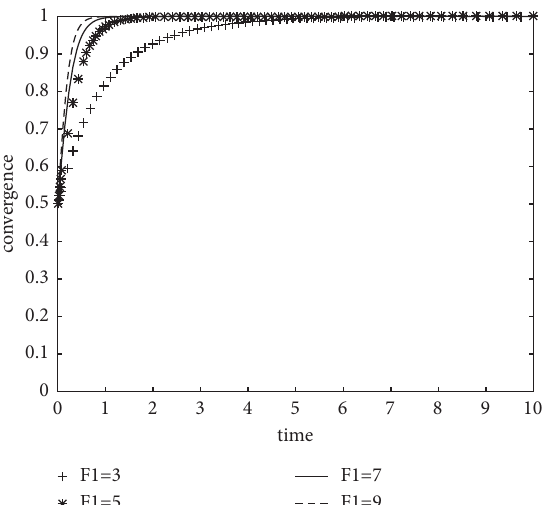
Figure 11: Impact of change F